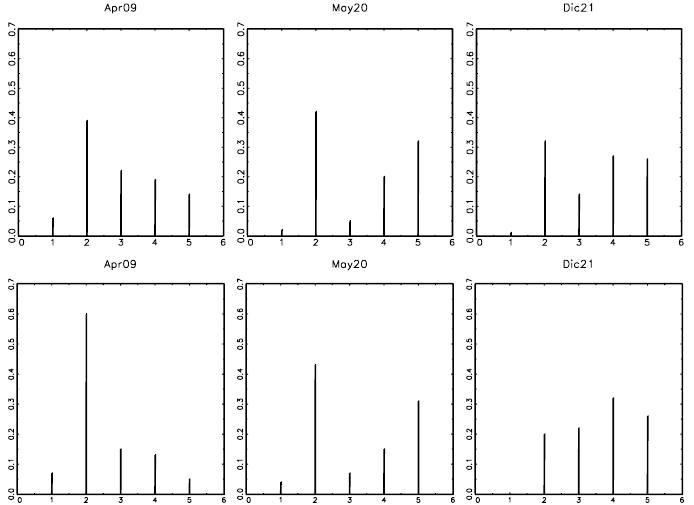
Figure 5. Frequency distributions of expectations about inflation by income quartile: Q1 ( first row ); Q4 ( second row